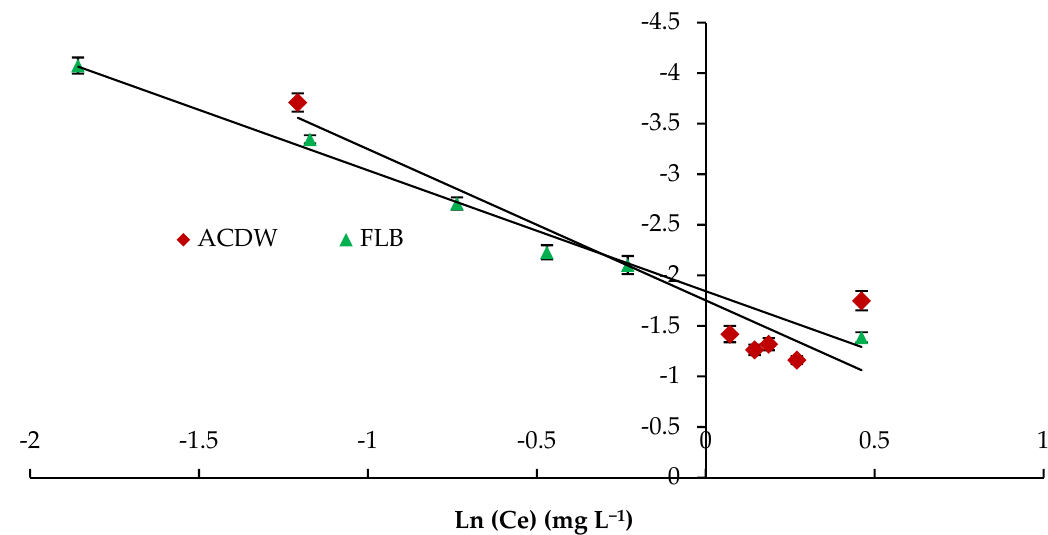
Figure 10. Tempkin isotherm plot for removal efficiency of IV2R dye.